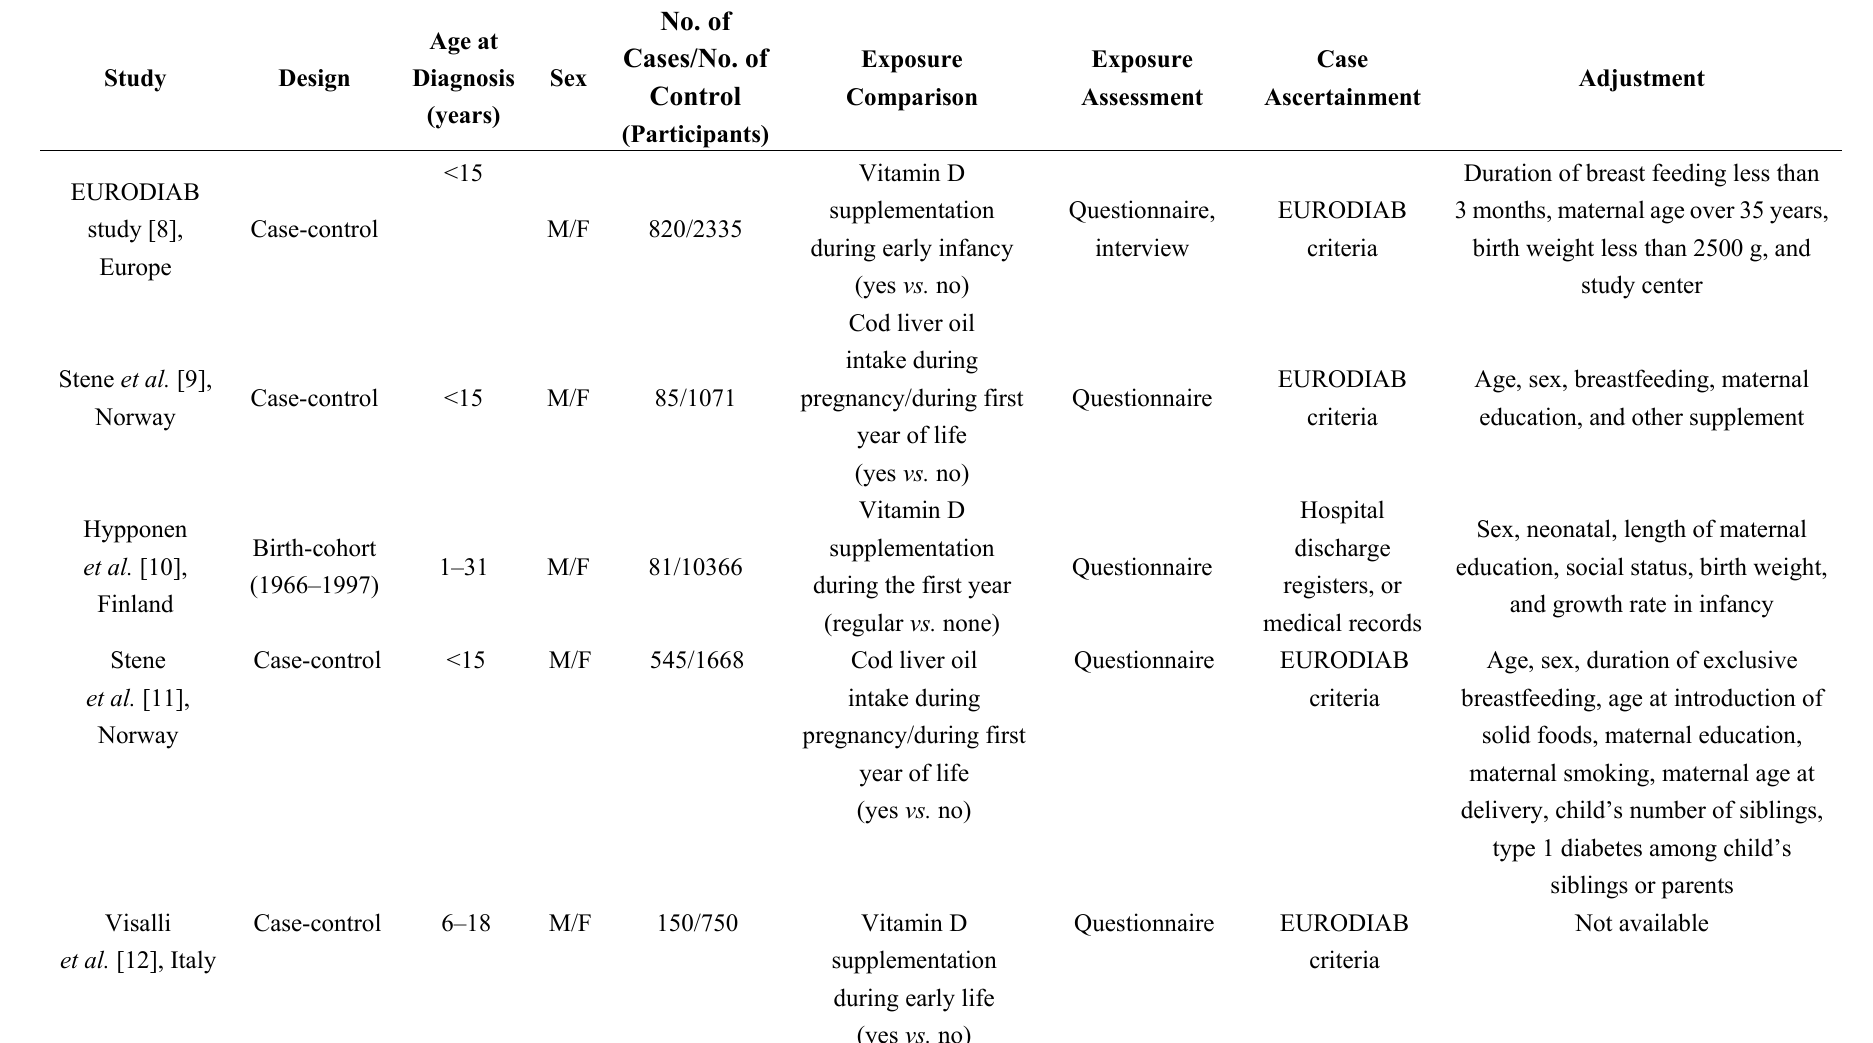
Table 1. Characteristics of observational studies on vitamin D intake and risk of type 1